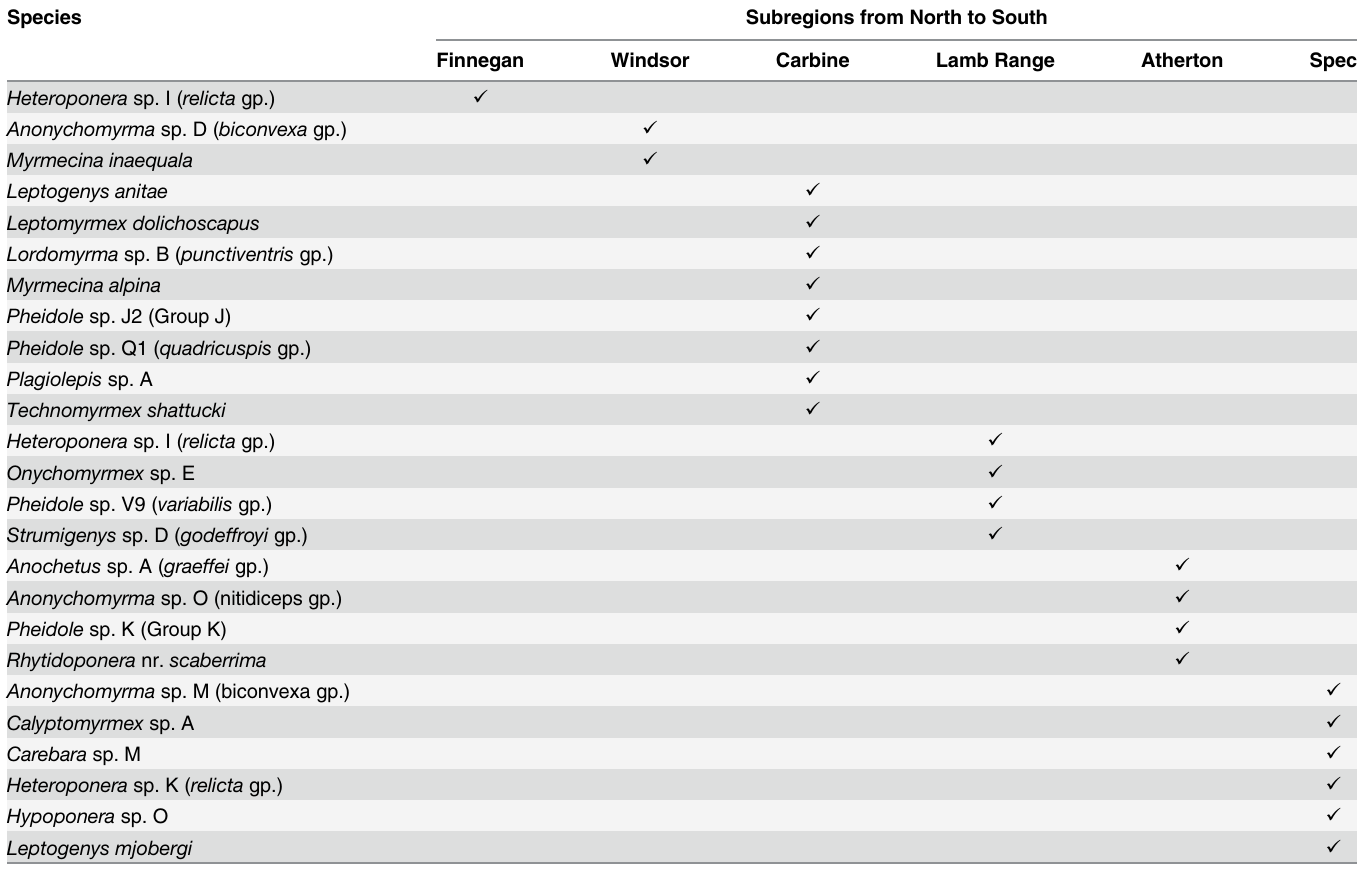
Table 1. Ant species occurring in at least three plots that were recorded from single subregions. Species Subregions from North to South Finnegan Windsor Carbine Lamb Range Atherton Spec Heteroponera sp. I ( relicta